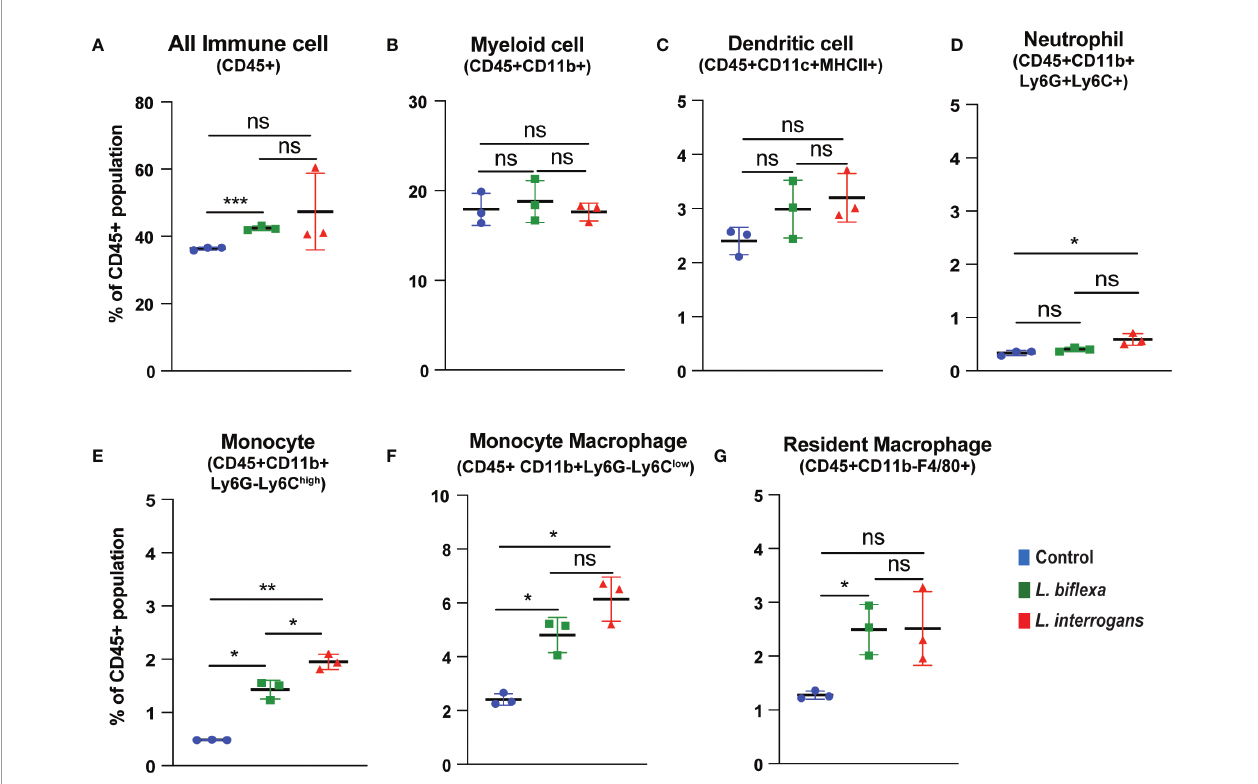
FIGURE 3 | Necroptotic cell death among different immune cells in spleen at 24h post infection. Annexin V + /PI + cells were considered as zone of necroptosis in (A) All Immune Cells, (B) Myeloid cell, (C) Dendritic cell, (D) Neutrophil, (E) Monocyte, (F) Monocyte-Macrophage and (G) Resident Macrophage. Plots are represented as % of CD45+ population. Statistical analysis was performed using unpaired student t-test with Welch ’ s correction, *p < 0.05, **p < 0.01, ***p < 0.001; n = 3 mice per group. ns, not-signi fi cant. Data represents one of two independent experiments; N = 7 mice per